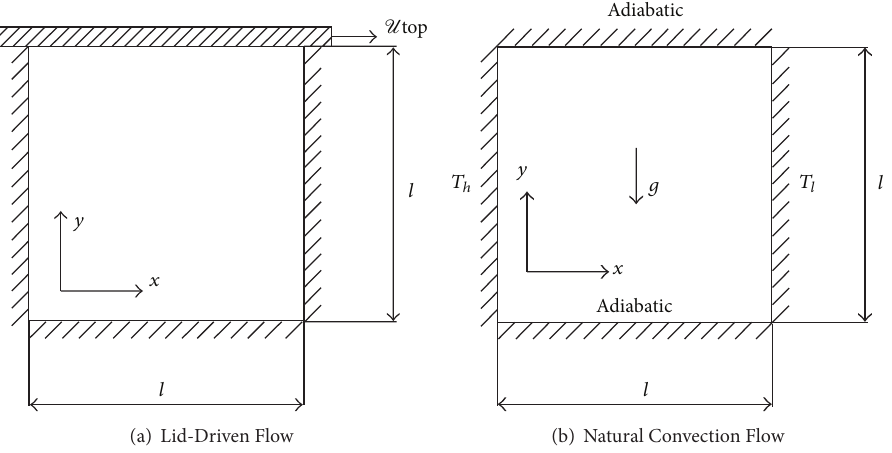
Figure 1: Schematic of different physical problem in a square cavity.